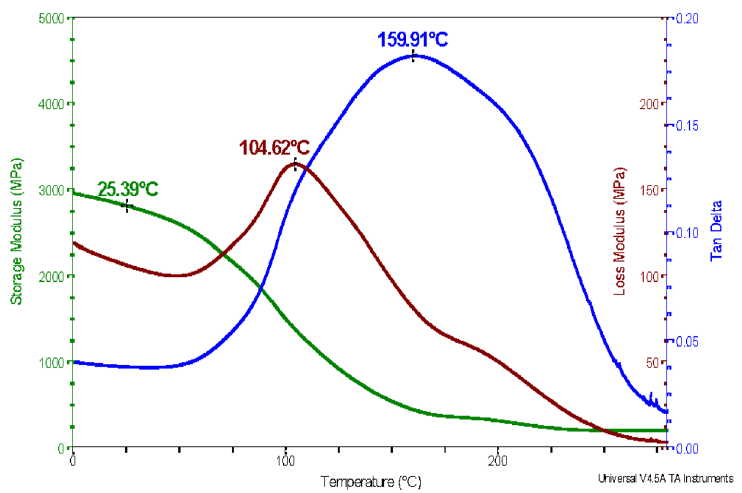
Figure 4. Thermal analysis curve of Polymer C obtained from single-frequency test.